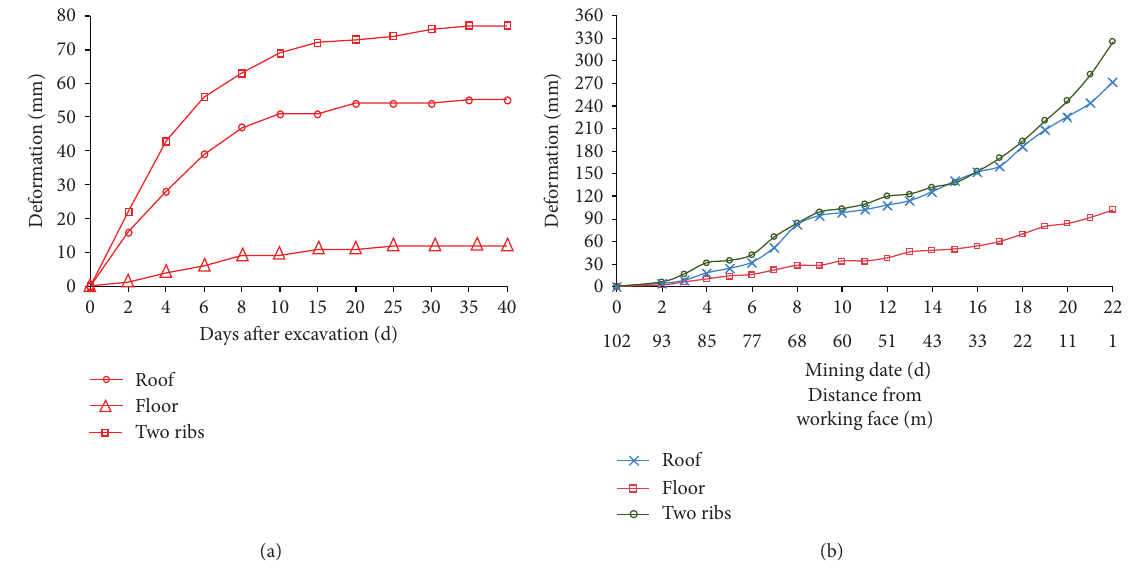
Figure 10: Deformation of gateway N1303 after support parameters optimization. Table 26: The Comparison of N1303 conveyer tunnel and tailgate N1303. Technical and economic